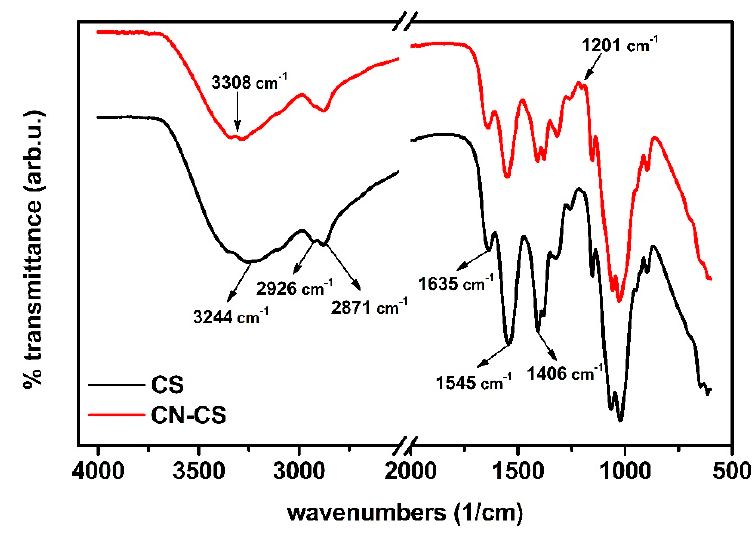
Figure 2. FTIR spectra of neat CS and CS reinforced by 10% of CN (CN–CS).